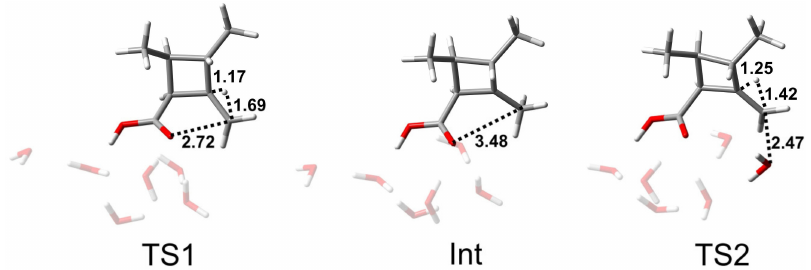
Figure 8. Structures of TS1, Int, and TS2 of the A AL 1 reaction path of CBL + 5H 2 O + H 3 O + . The unit of distance is Å.